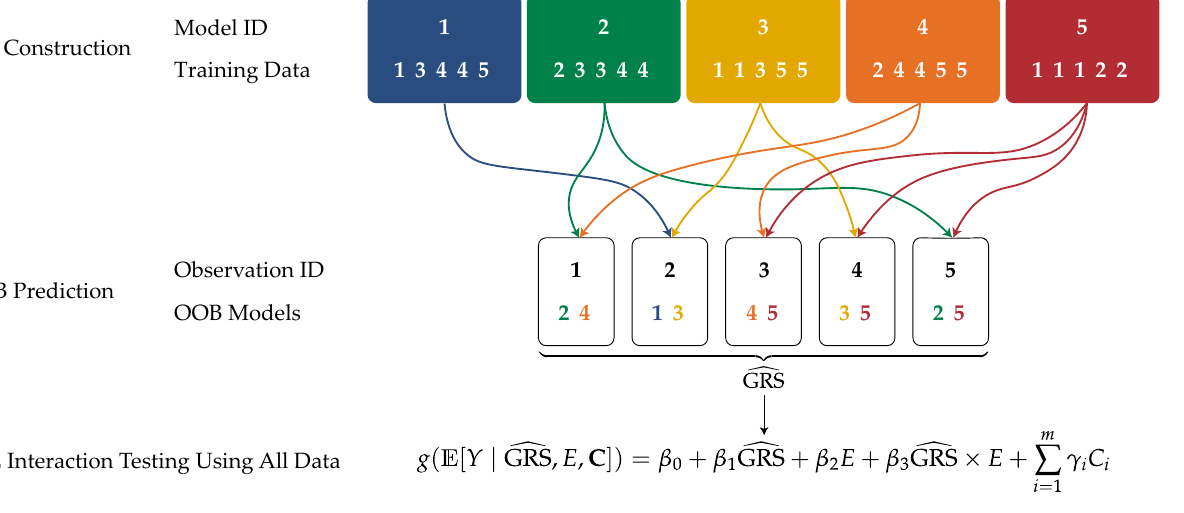
Figure 1. Exemplary GxE interaction testing workflow utilizing bootstrap aggregating. N = 5 observations and B = 5 bagging iterations are